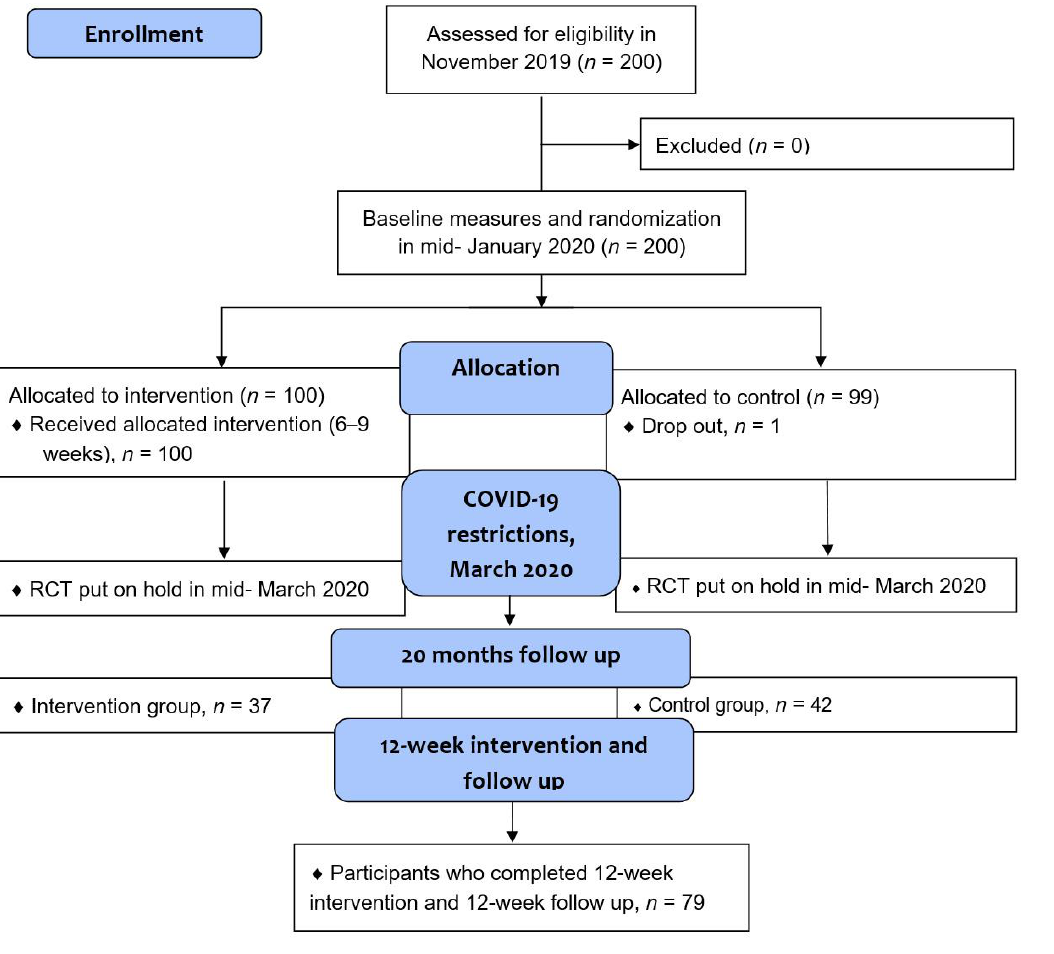
Figure 1. Flowchart. Figure 1.